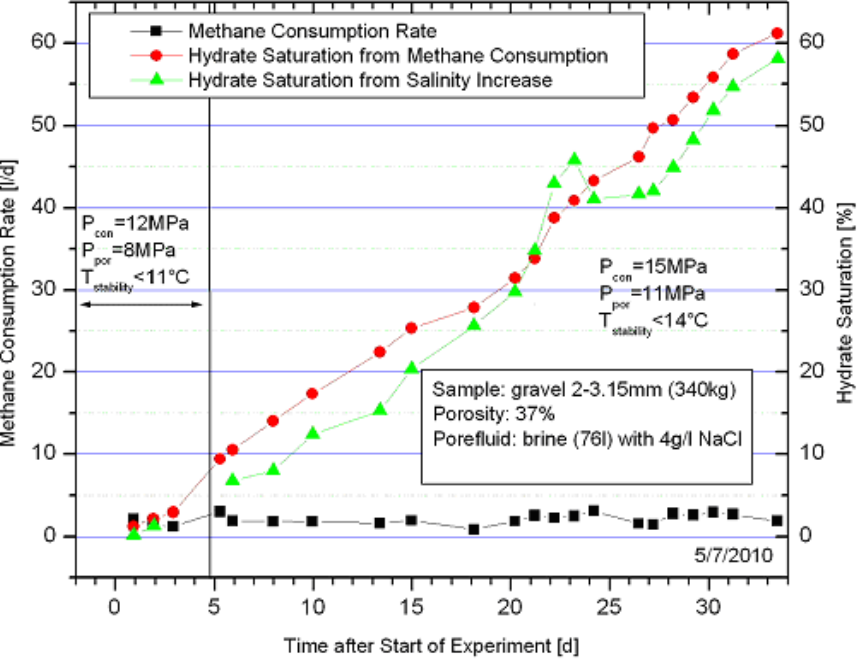
Figure 2. Increasing hydrate saturation in the sediment during the first experiment in LARS calculated from methane consumption and pore water